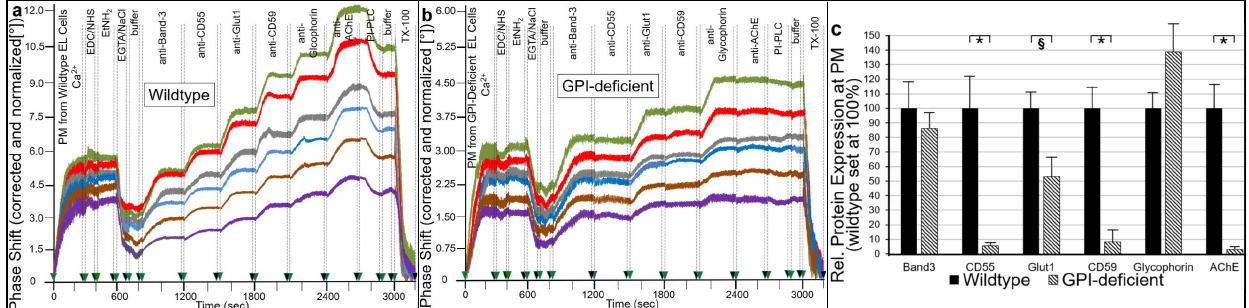
Figure 1. Inhibition of GPI-AP expression at PM of GPI-deficient EL cells. Wildtype and GPI-deficient EL cells were grown and used for preparation of PM. Following injection of 150 µ L of acceptor PM from wildtype (( a , c ) filled bars) or GPI-deficient (( b , c ) hatched bars) EL cells (0.15–0.20 mg protein/mL) together with Ca 2+ (ionic capture), 50 µ L of EDC/NHS were injected into the chips followed in sequential order by 100 µ L of 1 M EtNH 2 (covalent capture), 50 µ L of 1 mM EGTA/2 M NaCl and 50 µ L of buffer each at a flow rate of 30 µ L/min, 75 µ L of antibodies against GPI-APs or transmembrane proteins as indicated, 75 µ L of PI-PLC ( Bacillus cereus , 7.5 mU/mL), 25 µ L of washing buffer and 50 µ L of TX-100 (0.1%) each at a flow rate of 15 µ L/min. ( a , b ) PMs from six different cell clones were analyzed for phase shift by SAW sensing using different chips. Phase shift as a measure for expression of GPI-APs and transmembrane proteins at PM is given upon correction for unspecific interaction (no PM) and normalization for varying capturing efficacy of different chip channels (i.e., for identical amounts of PM captured). The experiment was repeated five times with similar results. Hatched vertical lines with green and black arrows indicate start and termination, respectively, of cycles of fluid injection at the time points indicated. ( c ) The values for the six different cell clones for wildtype and GPI-deficient EL cells each were corrected for identical phase shift induced by capture of the PM (at 815 s prior to antibody injection; GPI-deficient PM accounted for only 45–69% of the phase shift of wildtype PM) and then used for calculation of the phase shift ∆ induced by each antibody (anti-Band-3, ∆ 1200–800 s; anti-CD55, ∆ 1500–1200 s; anti-Glut1, ∆ 1800–1500 s; anti-CD59, ∆ 2100–1800 s; anti-Glycophorin-A, ∆ 2400–2100 s; anti-AChE 2700–2400 s). The mean values ± SD of the phase shift ∆ were used for calculation of the relative protein expression at PM, with wildtype EL cells set at 100% each and significant differences vs. GPI-deficient ones indicated (* p ≤ 0.01, § p ≤